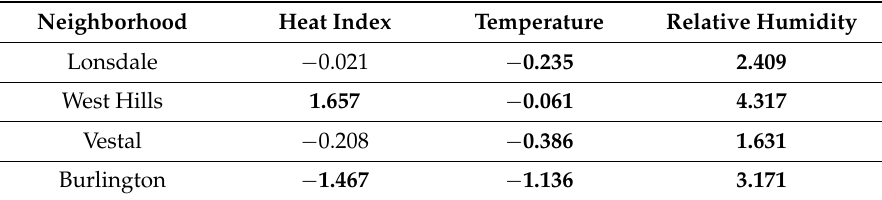
Table 5. Comparison of daily maximum heat index ( ˝ C), temperature ( ˝ C), and relative humidity (%) between MV and HV locations within each neighborhood. Mean differences are shown. Bolded numbers indicate significant results ( p < 0.05). Negative numbers indicate the HV location has a lower mean than the MV location in each